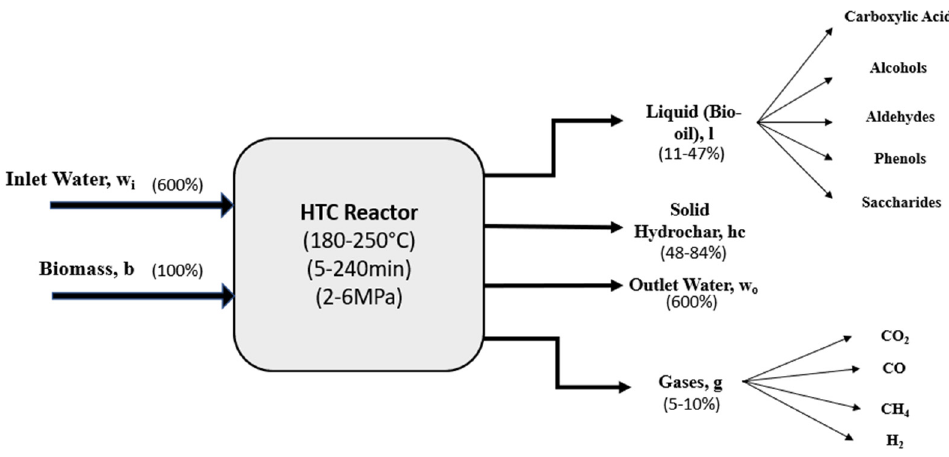
Figure 3. Input and output streams for HTC mass balance.